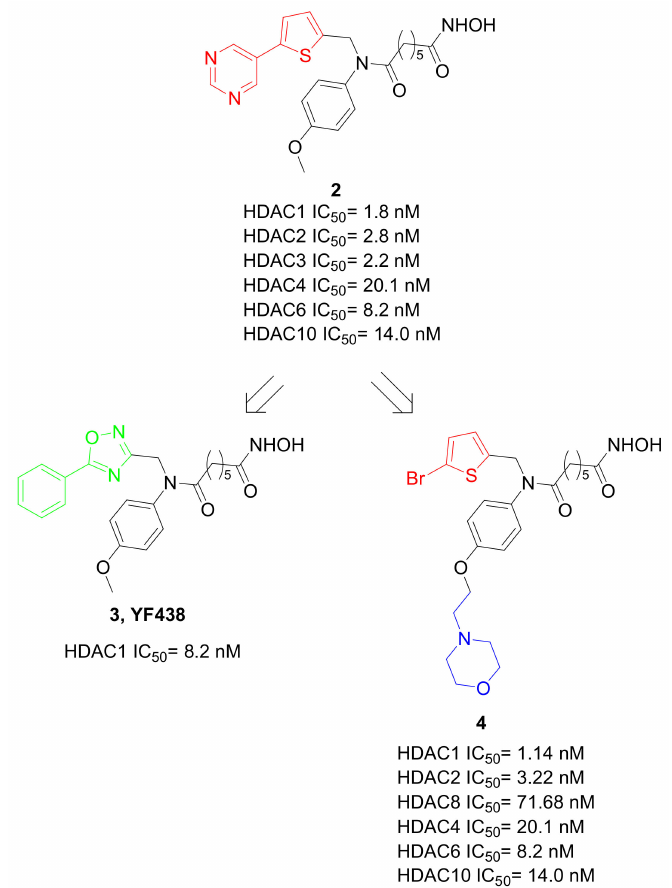
Figure 5. Chemical structures of hydroxamates HDACIs based on a bis-substituted aromatic amide scaffold.